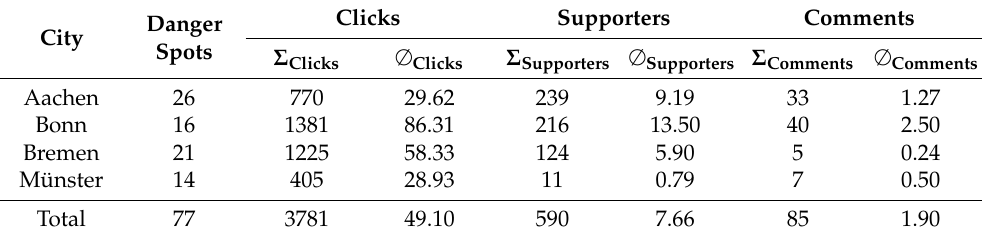
Table 2. User-related activity per city (in total ( Σ ) and average ( ∅ ) number) 1 . City